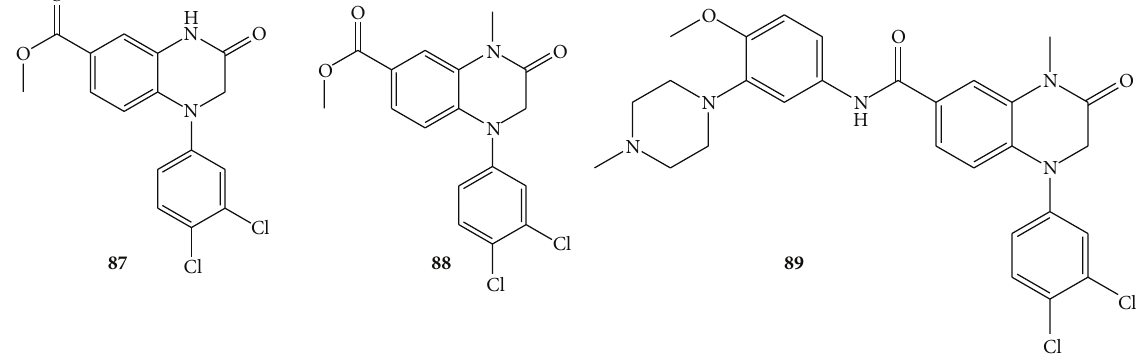
Figure 37: Chemical structures of compounds 87 – 89 .